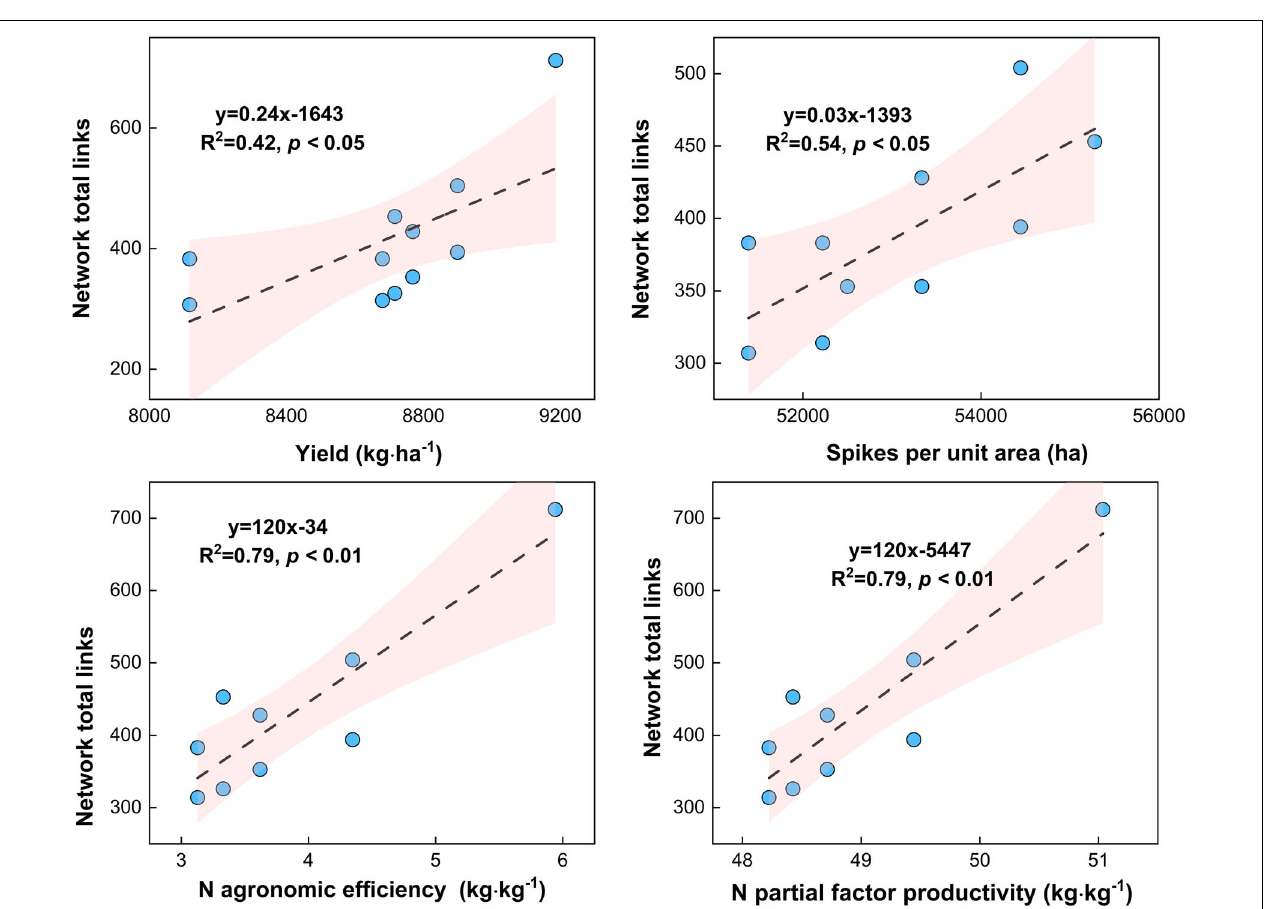
FIGURE 9 | Relationship between microbial network complexity with maize yield, spikes per unit area, N agronomic efficiency, and N partial factor productivity under different N fertilizer treatments (including CT, U, S, SU3, SU5, and